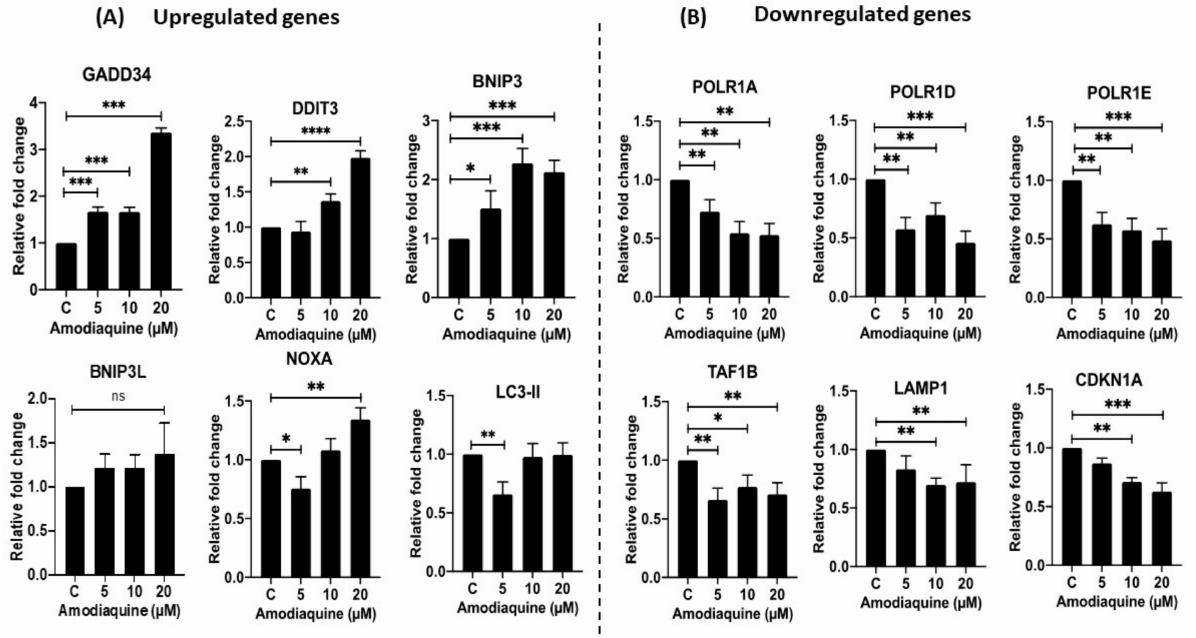
Figure 10. Gene expression analysis by RT-qPCR showing ( A ) upregulated and ( B ) downregulated genes in response to different amodiaquine concentrations in MDAMB-231 cells. Data for individual genes is represented as mean ± SD ( n = 3), * p < 0.05, ** p < 0.01, *** p < 0.001, **** p < 0.0001, compared between treatment and control group and among treatment groups as